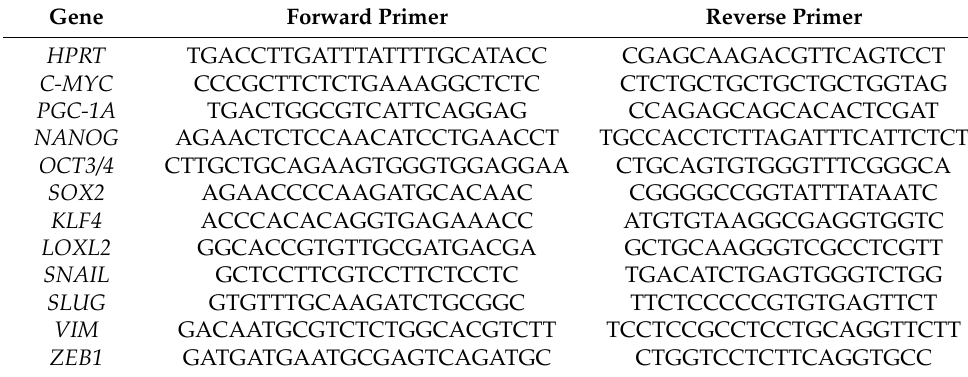
Table 1. List of primers used for real time